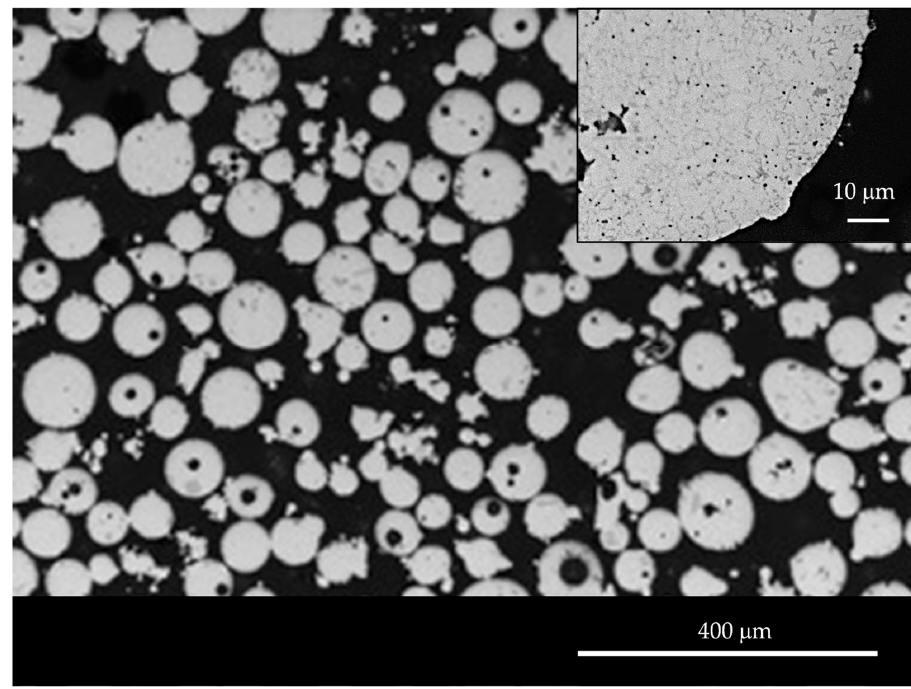
Figure 8. Optical microscopy atomized coarse powder before processing via PIT.